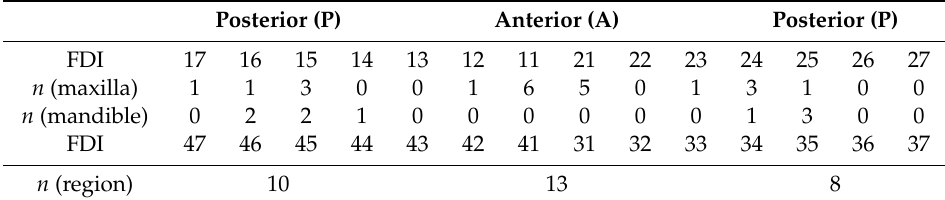
Table 2. RAI distribution and region.